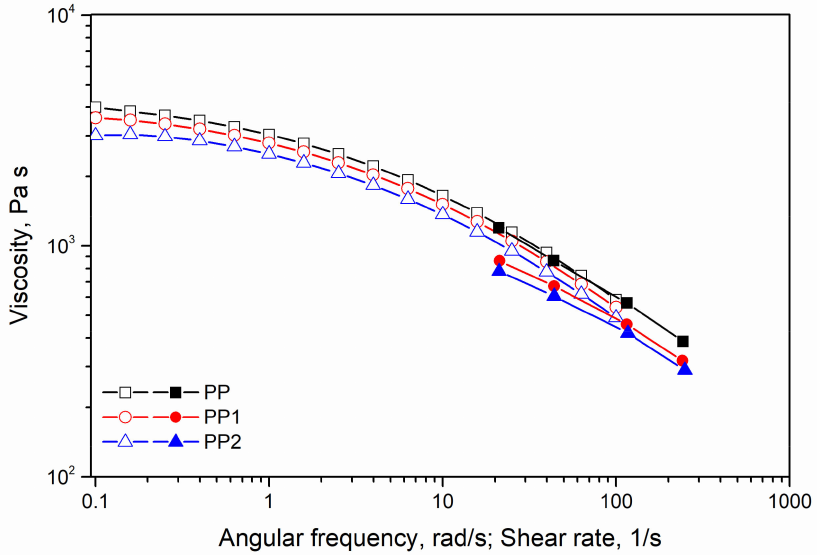
Figure 4. Flow curves of polypropylene and polypropylene nanocomposites. Date taken from rotational rheometer (open symbols) and capillary viscometer (closed